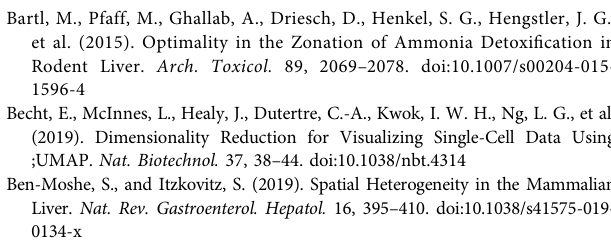
Supplementary Figure S1 | Validation of the liver zonation-related prognostic signature. (A,B) LASSO regression analysis determined the three-gene signature for OS prediction. (A) Cross-validation plot shows the con fi dence intervals for each lambda variable; (B) shows the trajectory of each independent variable, and the horizontal axis represents the log value of the independent variable lambda, while the vertical axis represents the coef fi cient of the independent variable. (C,D) Kaplan – Meier plot in ICGC cohort (C) and GSE14520 cohort (D) . (E,F) tROC curve of 25-gene signature in TCGA cohort (E) and ICGC cohort (F) (G) .Multivariate Cox regression analysis of clinical parameters and risk scores for